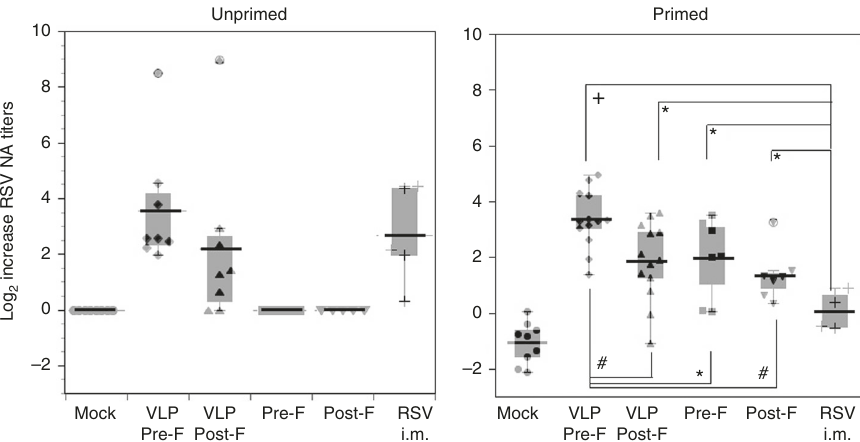
Fig. 3 Increase in dams ’ NA. Log 2 RSV NA titers in BV and BD samples were compared to determine the change in response ([Log 2 titer BD] − [Log 2 titer BV]) from each vaccine preparation administered to unprimed or primed dams. Each symbol represents one dam and the line across each group represents mean value. Boxes represent the boundaries of the quartile. Error bars represent s.e.m. Statistically signi fi cant boosting in primed animals was assessed by one-way ANOVA followed by Tukey test. * p < 0.05; # p < 0.0005; + p <